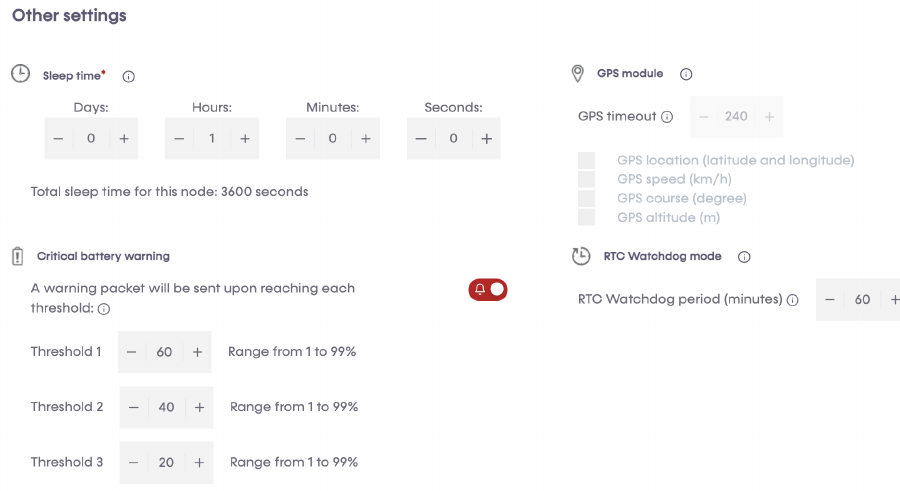
Figure 11. Other